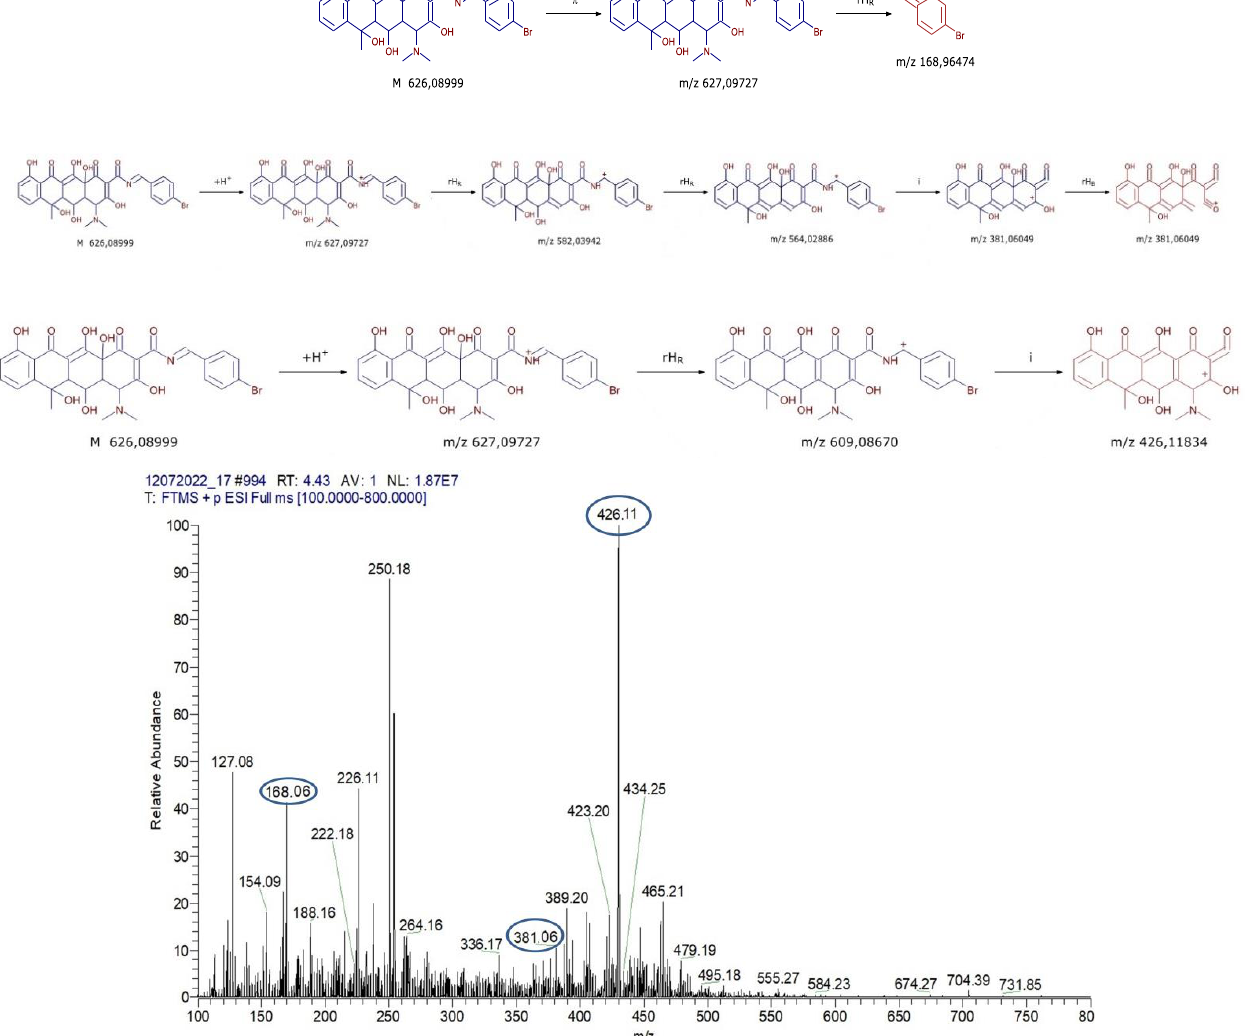
Figure 4. Fragmentation pattern generated by Mass FrontierTM and MS2 spectra for the derivate OXI-C.